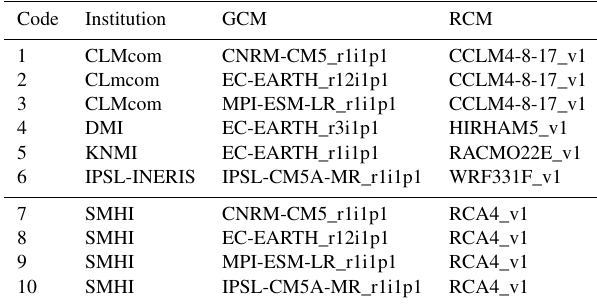
Table 3. Available Euro-CORDEX simulations at a 0.11 ◦ resolution ( ∼ 12km) over Europe, providing institutions, GCMs, and